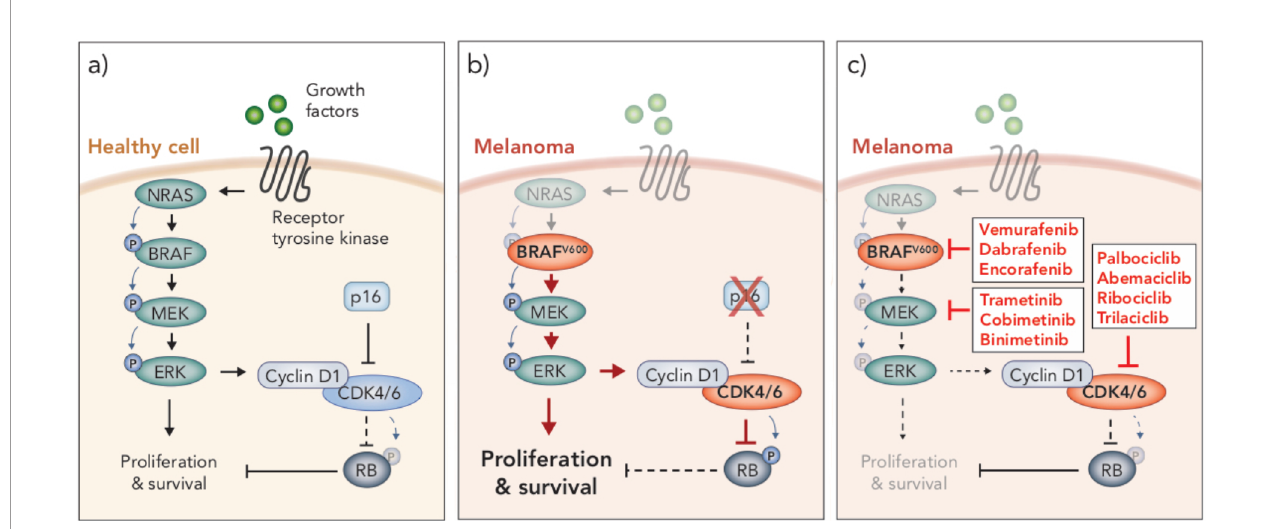
FIGURE 1 | MAPK/ERK and p16/CyclinD-CDK4/6/RB signaling pathways in health and disease. (A) In healthy cells, growth factors bind receptor tyrosine kinases on the surface of the cell to stimulate proliferation and survival through the MAPK/ERK signaling pathway, which is mediated through a cascade of phosphorylation events (NRAS ! BRAF ! MEK ! ERK). MAPK/ERK signaling promotes cyclin D1-CDK4/6 complex formation. Inhibition of CDK4/6 by p16 prevents CDK4/6- mediated phosphorylation of RB, thereby allowing RB to carry out its tumor suppressive function. (B) BRAF V600 mutations and loss of p16 are often seen in melanoma. BRAF V600 is constitutively active and promotes aberrant overactivation of MAPK/ERK signaling. In the absence of p16, CDK4/6 phosphorylates and inhibits the tumor suppressor RB. These events lead to uncontrolled cellular proliferation and survival. (C) Clinical inhibitors against BRAF V600 , MEK and CDK4/6 block MAPK/ERK signaling and CDK4/6-mediated suppression of RB, thereby attenuating cell cycle and